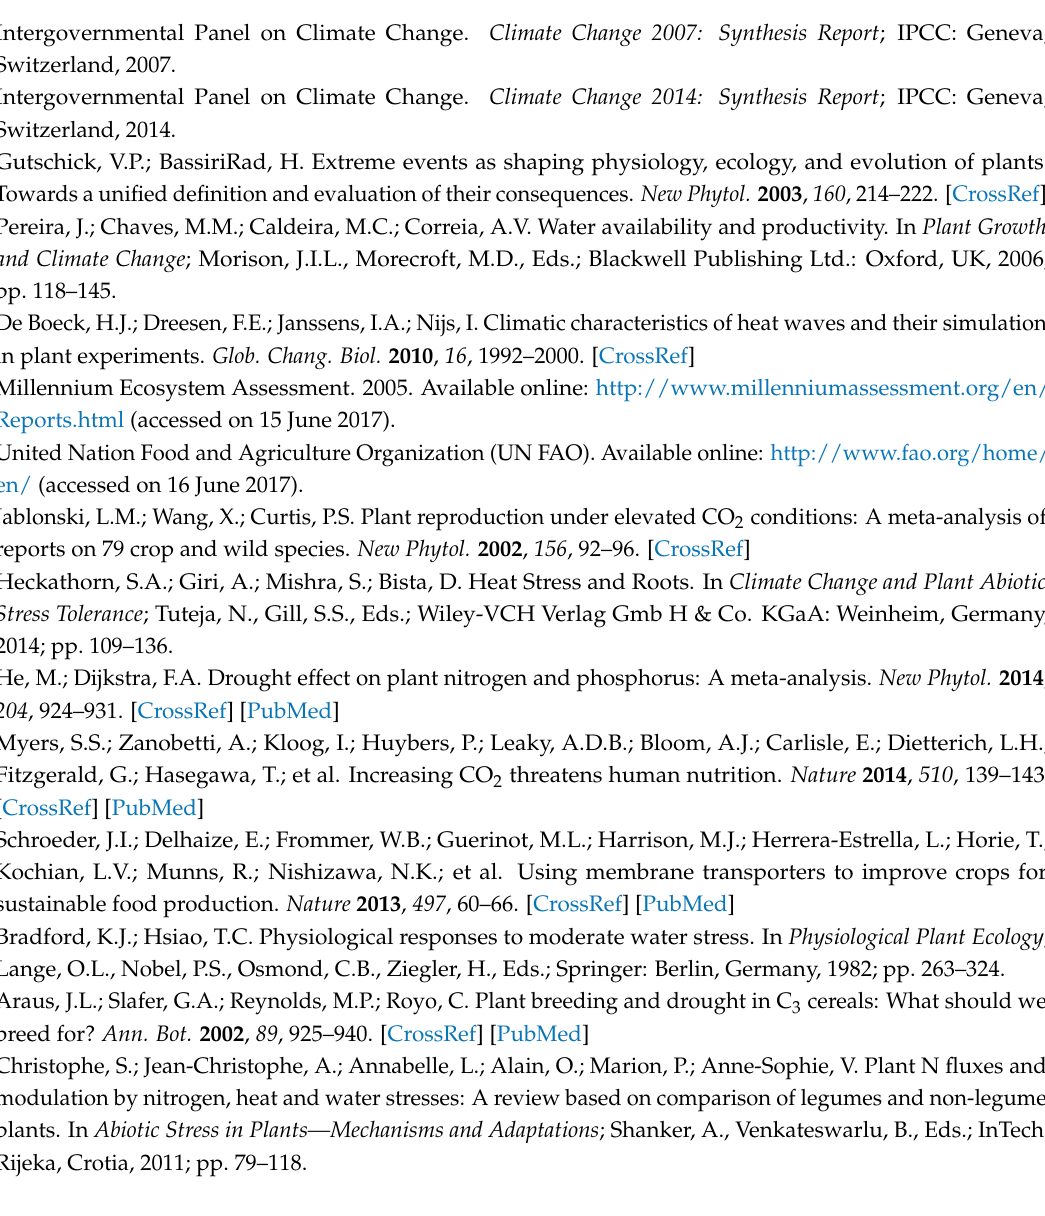
Figure S1: Effects of control vs. drought treatments on leaf stomatal conductance to water vapor (G s ) in barley, corn, and big bluestem (BBS). Each bar represents mean + 1 SE (standard error). Within each panel, bars not sharing the same letters are significantly different. For each response variable, significant effects of drought (ANOVA), across both harvest in corn and big bluestem, are indicated with an asterisk (*). Table S1: Results ( p values) from ANOVA statistical analyses for Barley. Table S2: Results ( p values) from ANOVA statistical analyses for Corn. Table S3: Results ( p values) from ANOVA statistical analyses for Big